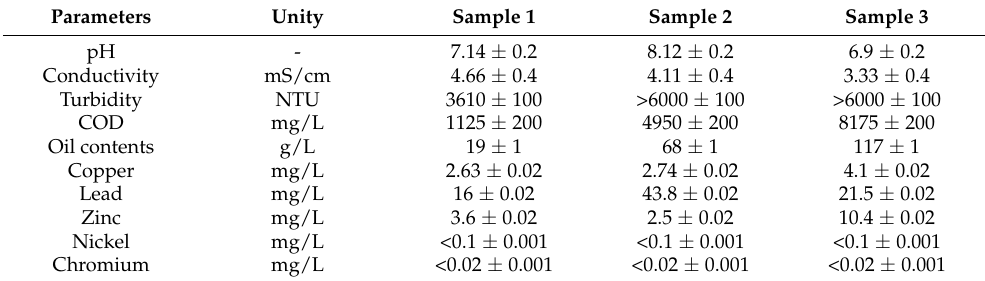
Table 1. Physicochemical characteristics of the industrial oily wastewater contaminated with heavy metals collected over three months.